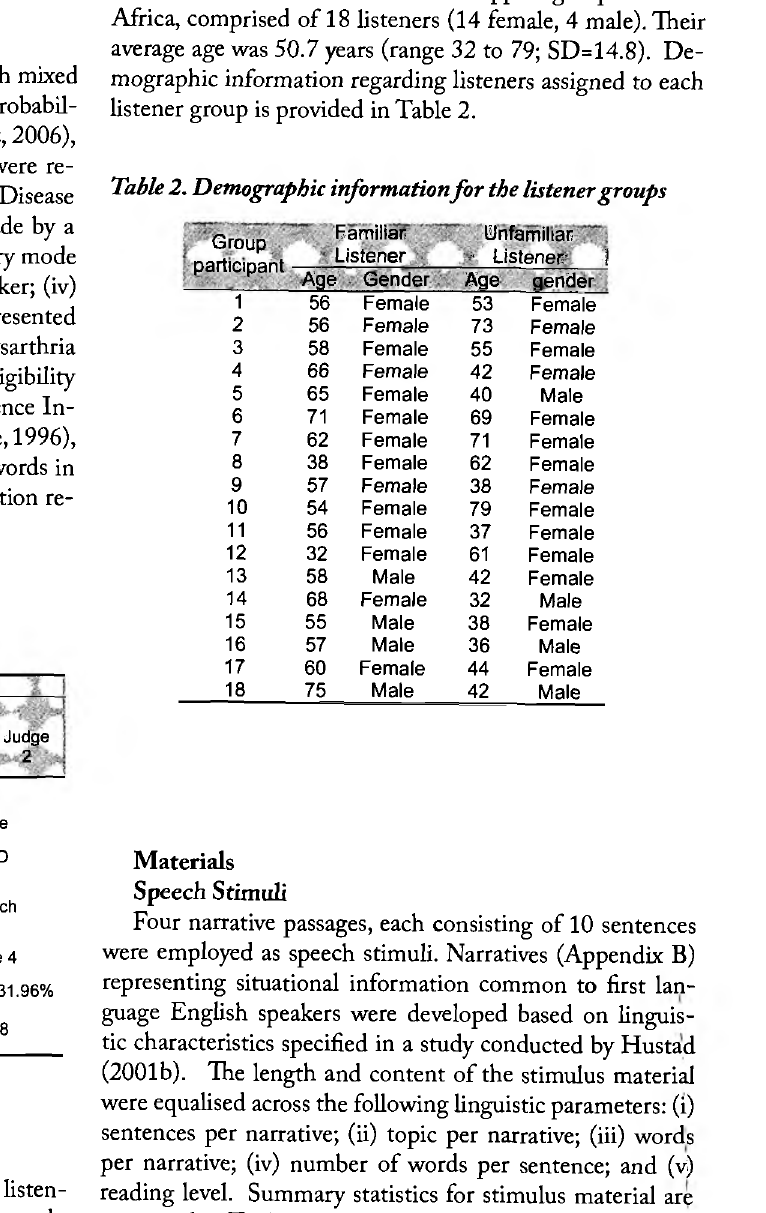
Table 3. Linguistic characteristics o f